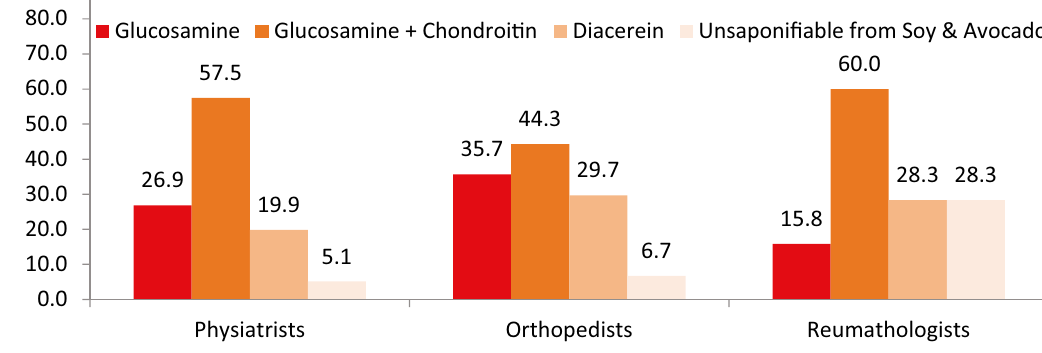
Figure 4 – SYSADOA options for AO treatment among